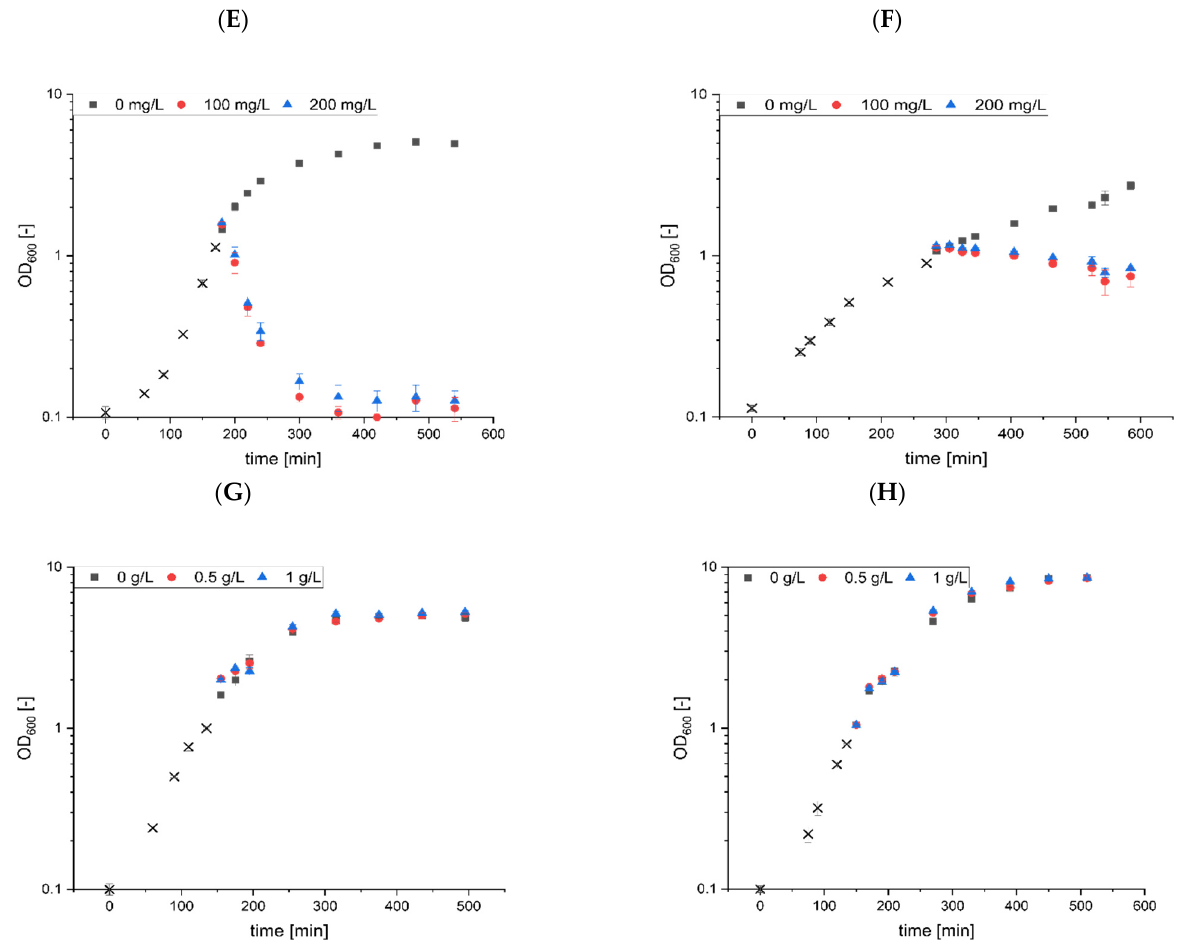
Figure 2. Stress approaches with biotechnologically established strains using rhamnolipids and sophorolipids. Cell growth of B. subtilis KM0 ( A , E ), C. glutamicum ATCC13032 ( B , F ), E. coli BL21 (DE3) ( C , G ) and P. putida KT2440 ( D , H ) was monitored in LB medium. After reaching an OD 600 of approximately 1 (black crosses), increasing concentrations of rhamnolipids ( A – D ) or sophorolipids ( E – H ) were added to equal volumes of the cell culture. Cell growth was monitored for further 6 h after stress induction. All stress approaches were performed in biological triplicates.